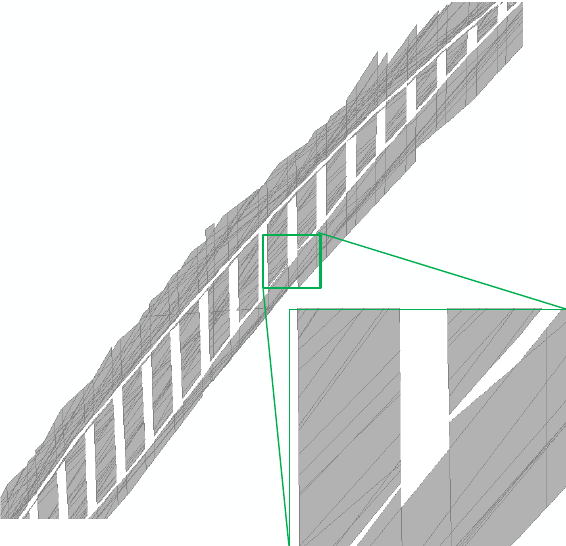
Figure 16. Traffic marking extraction calculated with average